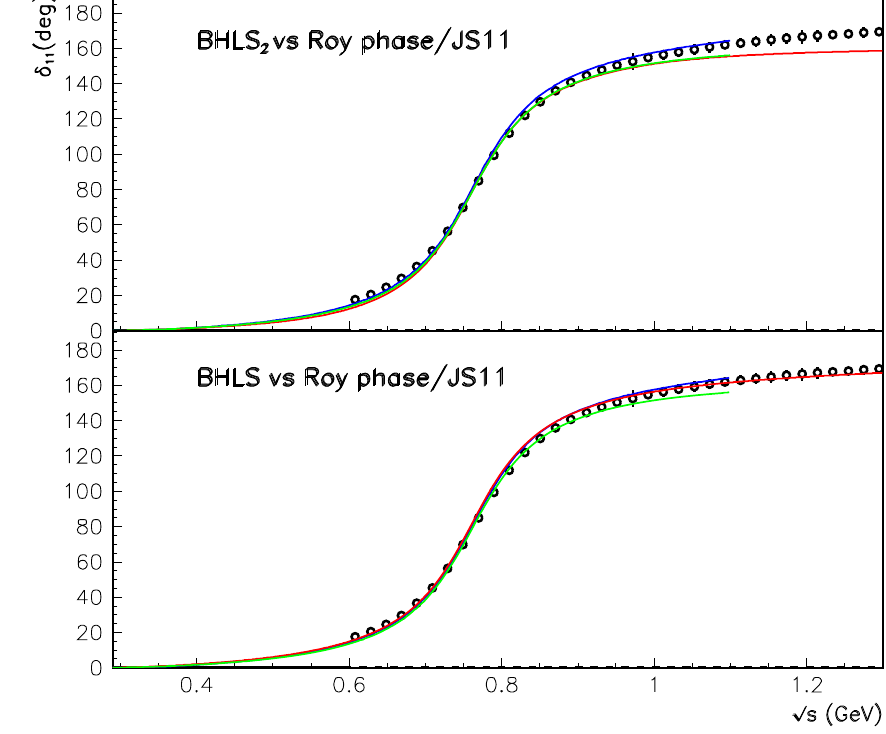
Fig. 10 The δ 11 ππ phase shift: In both panels, one displays the CERN-Munich data [118], the phase shift from [43] (JS11) is shown by the green curves and the blue curves are the phase shift from [119] based on the Roy equations. The red curves display the predictions from BHLS 2 (top panel) and from BHLS [25,27] (bottom panel) using the pion form-factor amplitude amputated from its ω and φ